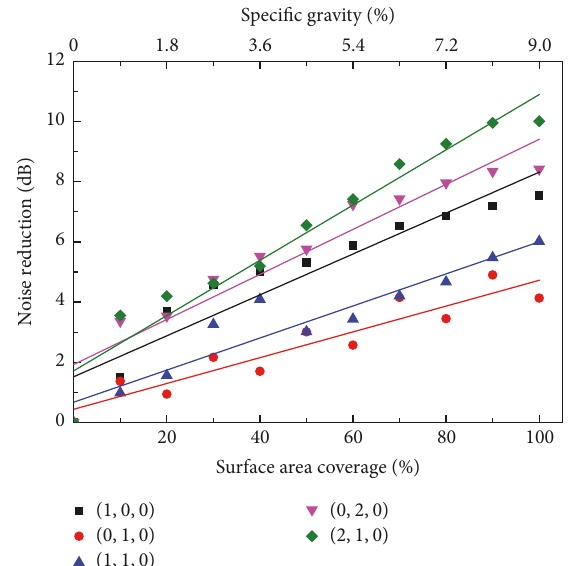
Figure8:Curvesofnoisereductionwithchangingoflayingrateand proportion